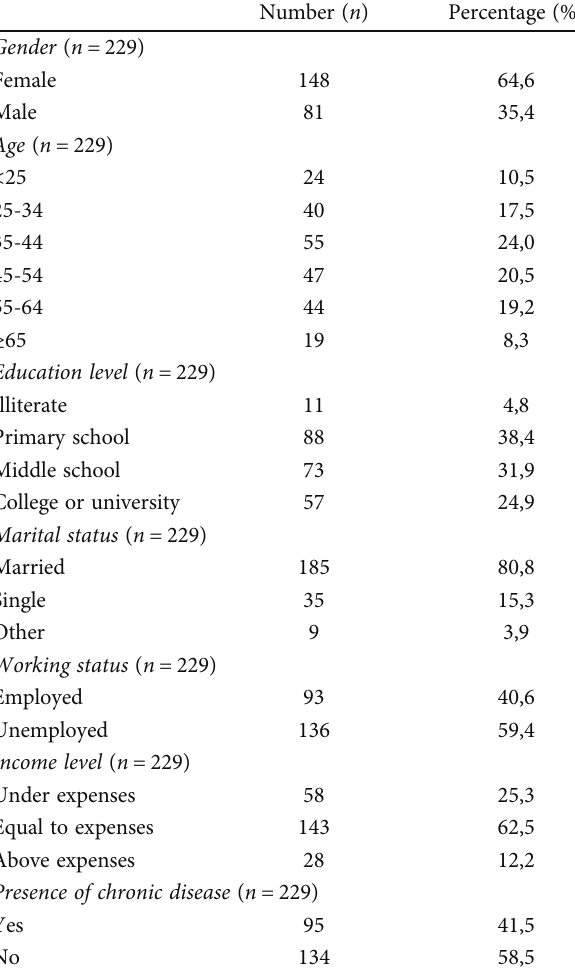
Table 1: Some descriptive features of the participants, Kastamonu, 2022.